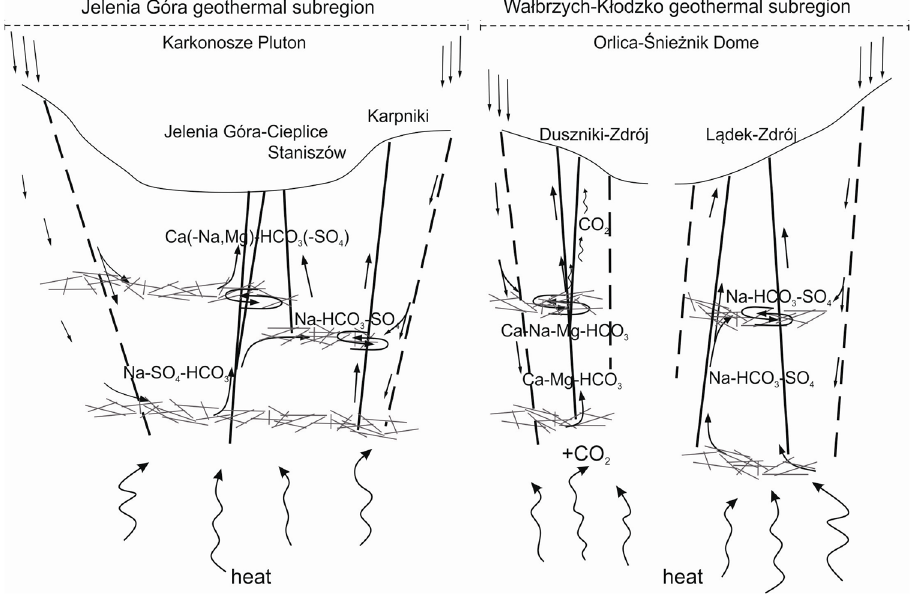
Figure 9. S implified schematic cross-sections of the Jelenia Góra and the Wa ł brzych-K ł odzko geo- Figure 9. Simplified schematic cross-sections of the Jelenia G ó ra and the Wałbrzych-Kłodzko geother- thermal subregions (based on [49,77]). mal subregions (based on